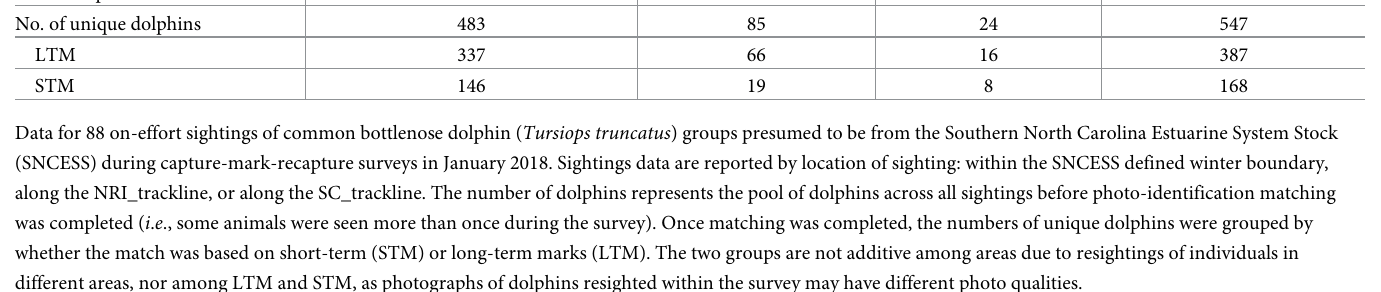
Table 2. Number of groups and individuals of estuarine-resident common bottlenose dolphins ( Tursiops truncatus ) sighted during the 2018 capture-mark-recap- ture abundance survey in southern North Carolina. Parameter Defined SNCES Boundary NRI_Trackline SC_Trackline